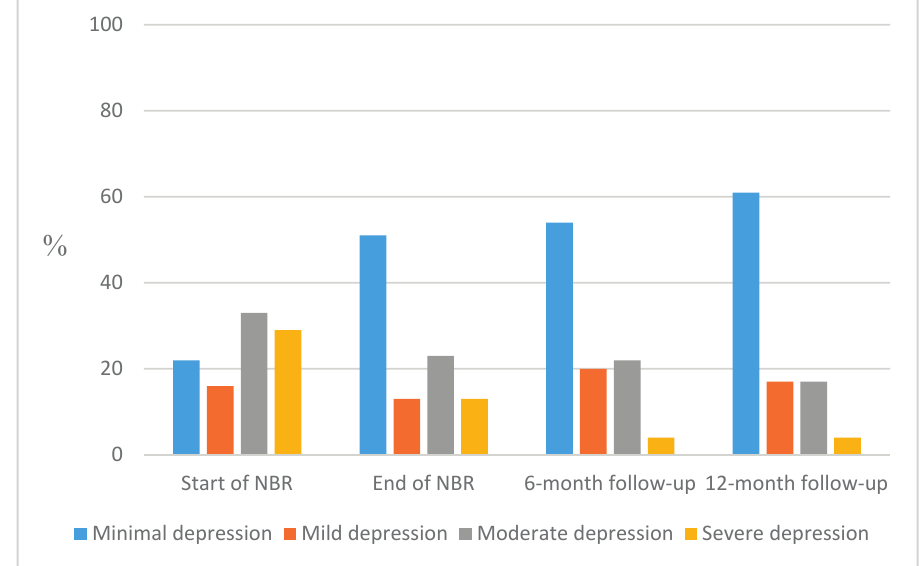
Figure 5. Proportions of participants with grand sum according to the standardized cut-offs for BDI-II: minimal (0–13), mild (14–19), moderate (20–28) and severe depression (29–63) measured at start of NBR and follow-up at end of NBR, and after six and twelve months, respectively.